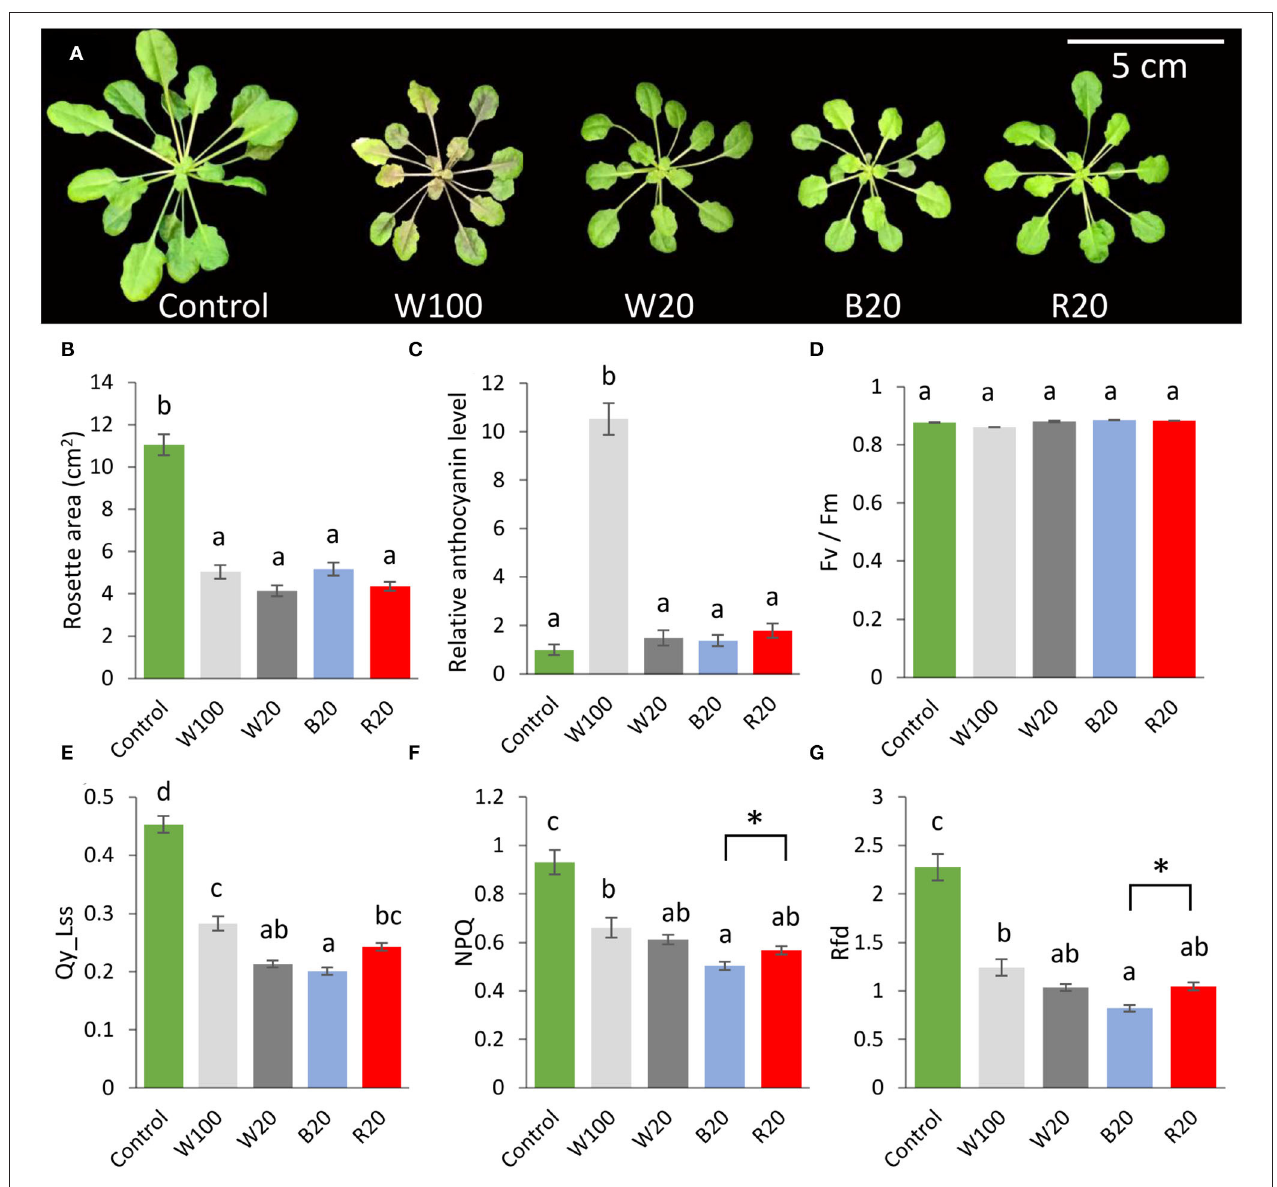
FIGURE 1 | Light intensity and quality modulate Arabidopsis response to low temperature. (A) Representative images of Arabidopsis Col-0 plants grown for 7 days in indicated conditions. (B) Rosette area. (C) Relative anthocyanin contents normalized to dry weight (relative to non-treated control plants). (D) The maximum quantum efficiency of photosystem II in the dark-adapted state. (E) Quantum efficiency of photosystem II in light steady state. (F) Non-photochemical quenching in light steady state. (G) Photosynthetic parameter Rfd (fluorescence decline ratio in light steady state). Results are means of three biological replicates, error bars indicate standard errors, and letters in all panels indicate significant differences according to one-way ANOVA with Tukey’s HSD post hoc test ( p < 0.05). Asterisks indicate significant differences according to Student’s t -test between marked variants ( p < 0.05). W100, cold treatment under 100 µ mol m − 2 s − 1 white light; W20, cold treatment under 20 µ mol m − 2 s − 1 white light; B20, cold treatment under 20 µ mol m − 2 s − 1 blue light; R20, cold treatment under 20 µ mol m − 2 s − 1 red light. For details, see Materials and